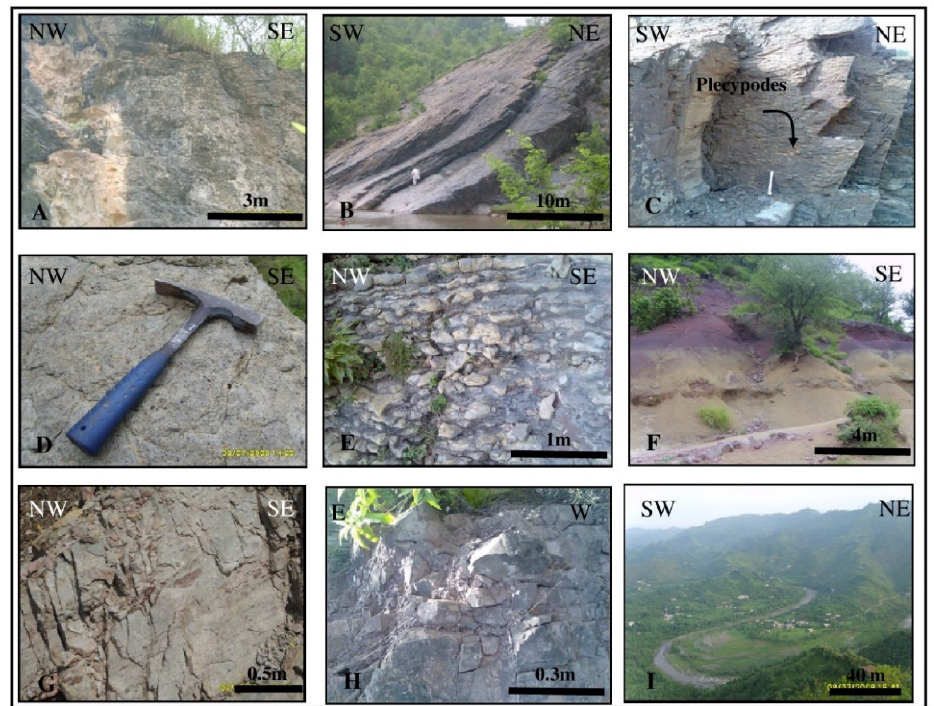
Figure 3. ( A ) The dolomite of Muzaffarabad Formation showing chop board weathering. ( B ) The bauxite and clay of the Hungu Formation are exposed in the Dandli area. ( C ) Plecypodic beds in shaly limestone of Patala Formation exposed near Gradh junction. ( D ) The shales of Margalla Hill Limestone showing larger forams. ( E ) Thinly bedded nodular limestone with alternate shales of Chorgalli Formation exposed near Gradh. ( F ) Variegated shales of Kuldana Formation exposed at Bhabra. ( G ) Fractured and jointed sandstone of Murree Formation exposed near Dara area. ( H ) Rip ups in the Murree Formation. ( I ) Cultivated river terraces in the Dandli